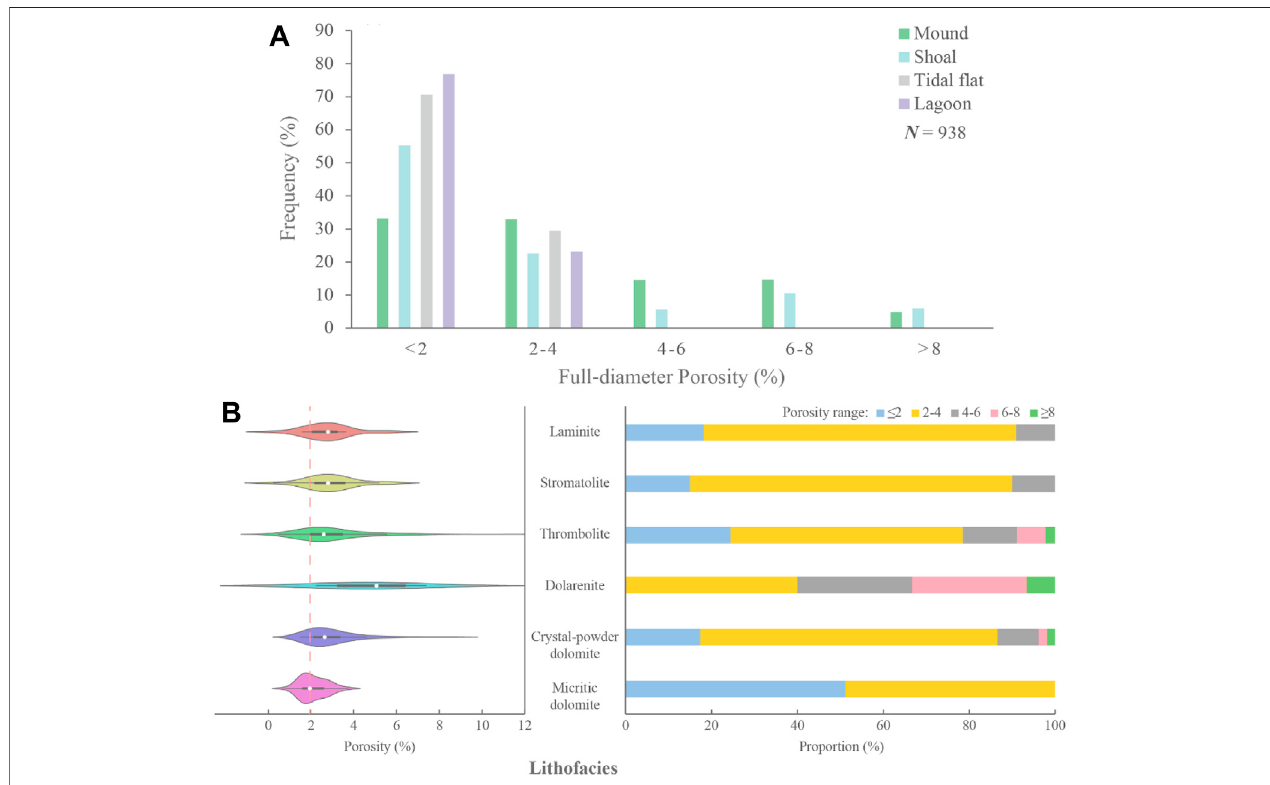
FIGURE7|(A) porosity distribution histogramofvarious sedimentary facies(data derivedfrom Houetal.(2021)); (B) violinplot(left panel) ofdiverselithofaciesand corresponding proportion of different porosity ranges in the lithofacies (right panel).